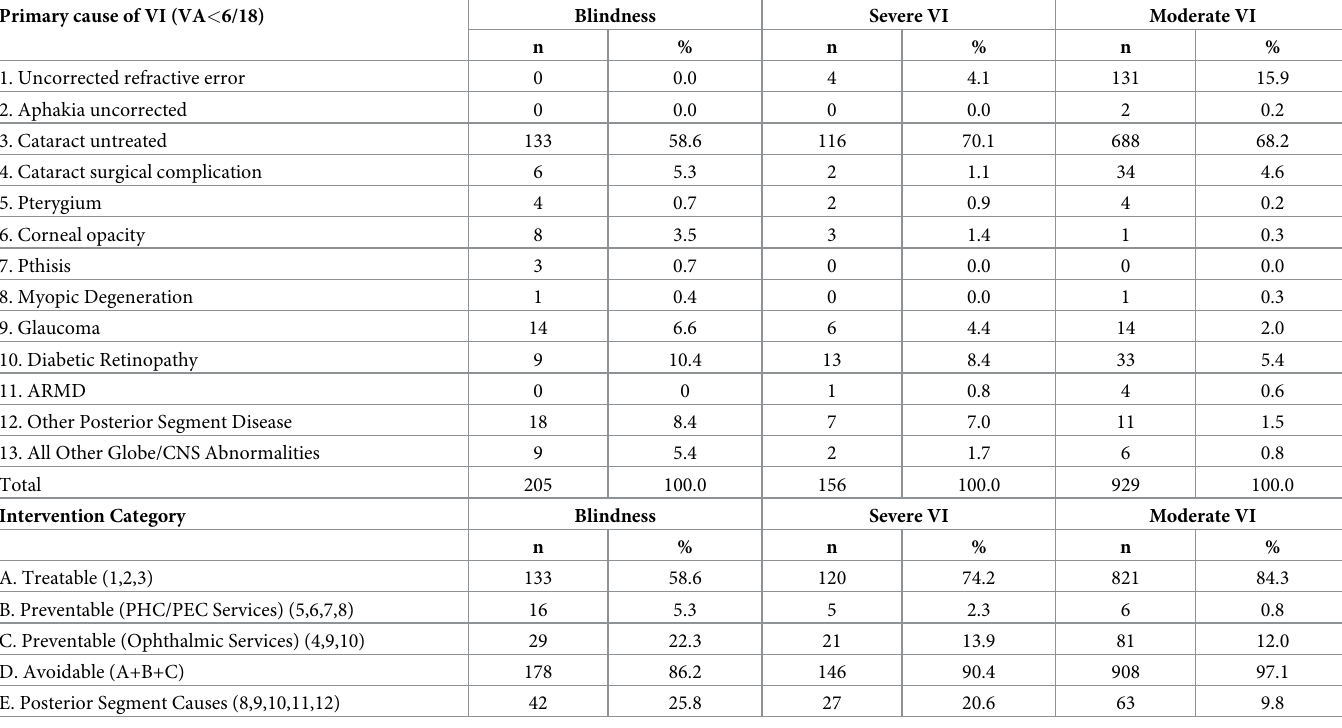
Table 3. Principal causes of blindness and visual impairment by person. Primary cause of VI (VA <